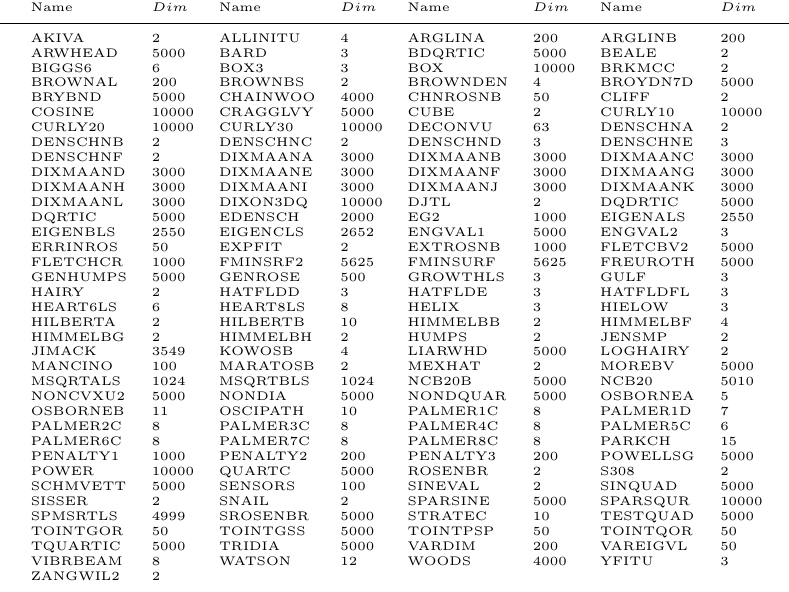
Table 1. Specifications of the test functions